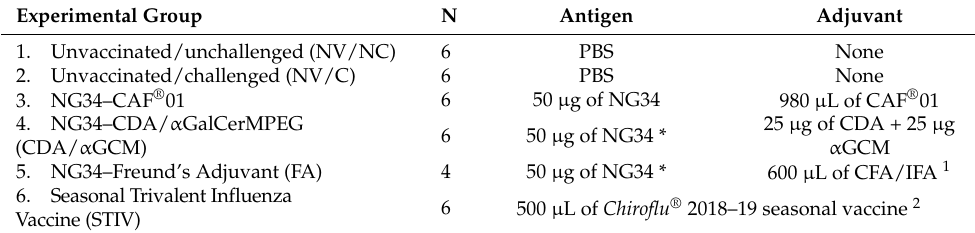
Table 1. Distribution of experimental groups and composition of the different antigen and adjuvant